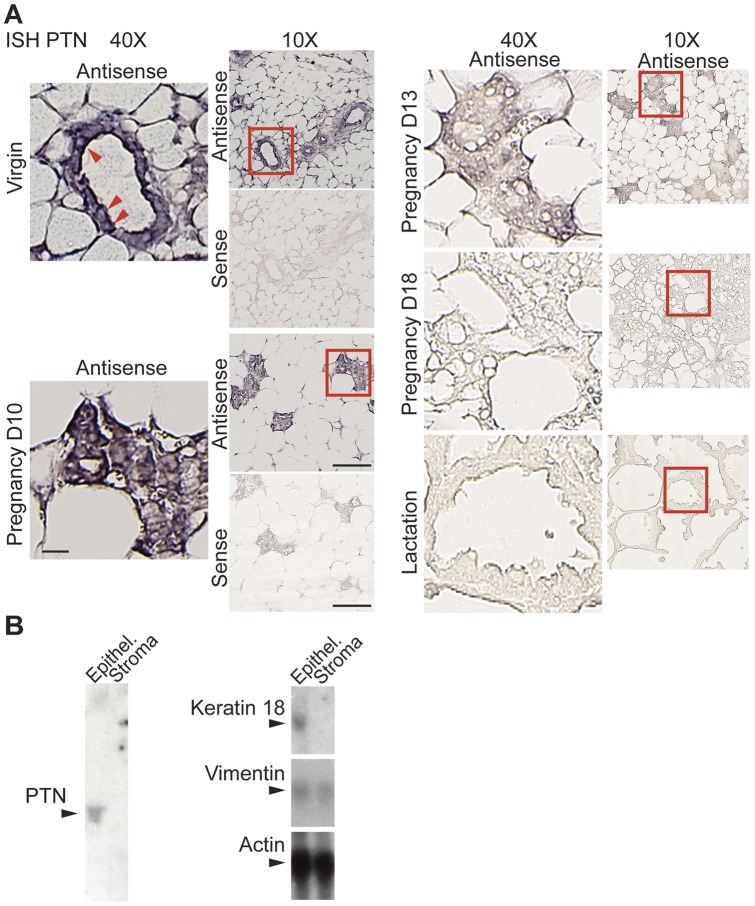
Mammary gland tissue distribution of PTN mRNA.(A) In situ hybridization (ISH) with PTN mRNA antisense and sense probes. Red squares indicate the areas shown at higher magnification. Scale Bars  = 25 μm and 100 μm respectively. Red arrowheads indicate PTN mRNA expression in mammary epithelial cells. (B) Northern blot for PTN mRNA in virgin mammary glands fractionated into epithelial and stromal cells.